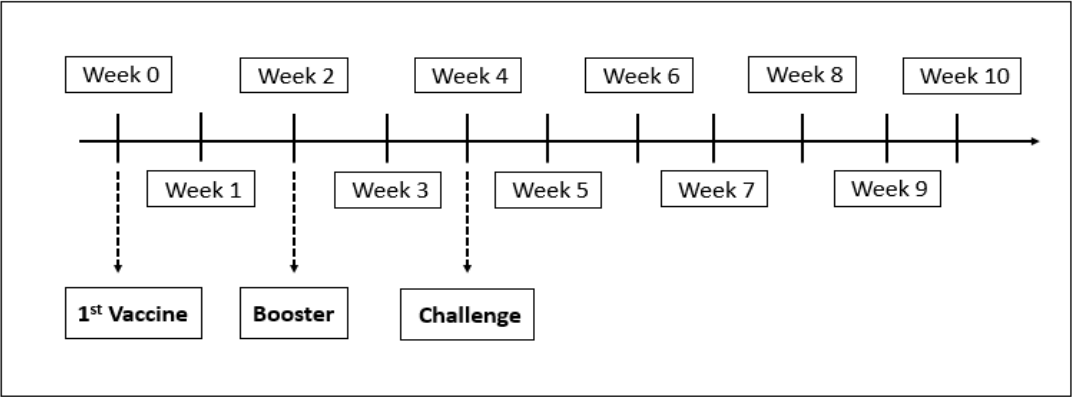
Figure 1. Timeline of the vaccination regime and challenge assay for Group 1 and Group 2.